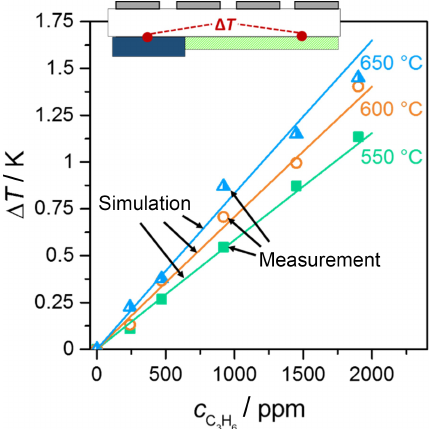
Figure 5. Calculated propene concentration for different feed gas concentrations in the first micron of the catalyst layer on coupling a 3-D and 1-D geometry. By this coupling, a very fine resolution of the catalytic layer thickness can be achieved. The scheme at the top should illustrate where the concentration is evaluated.